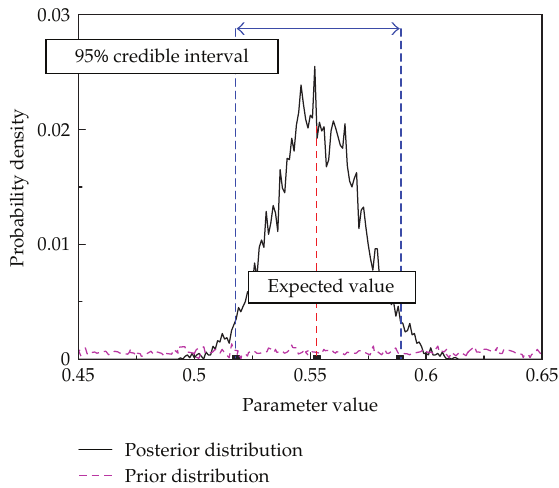
Figure 6: Probability distribution of parameter ω 73 (cid:6) 1 (cid:7) .